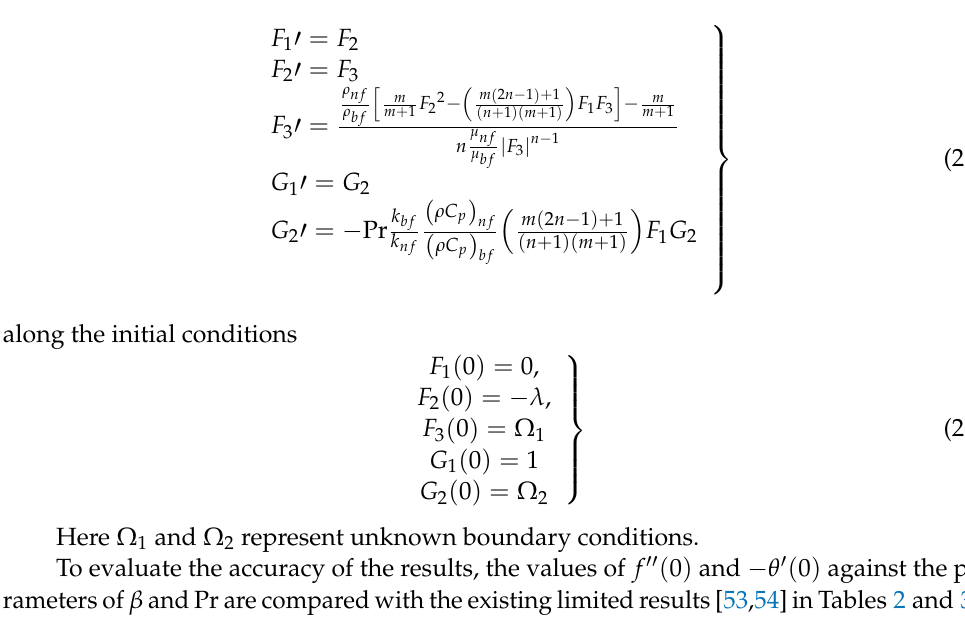
Table 2. Comparison of results for f (cid:48)(cid:48) ( 0 ) with numerical results in [53] when φ = 0 and n = 1. β